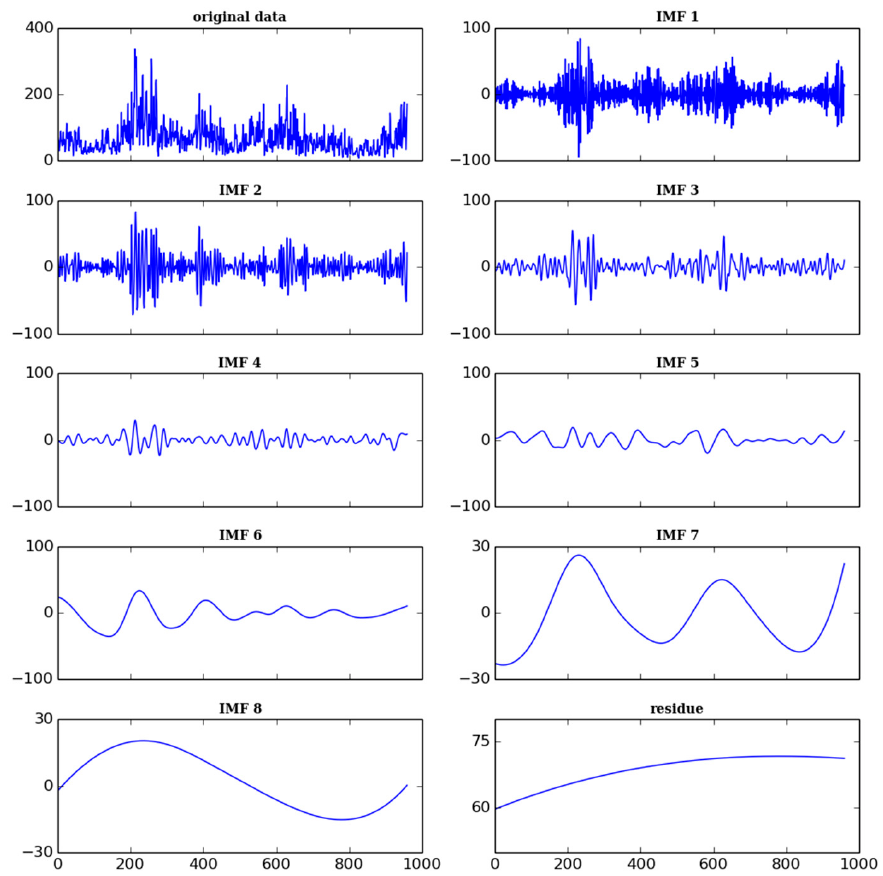
Figure 7. CEEMDAN decomposition of PM 2.5 concentrations for three years.